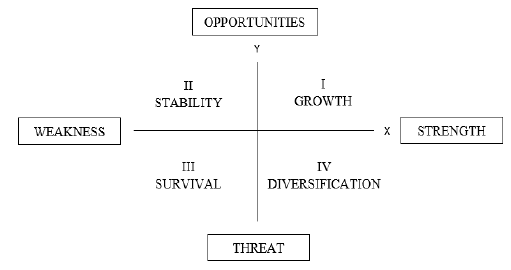
Figure 5 . SWOT-4K